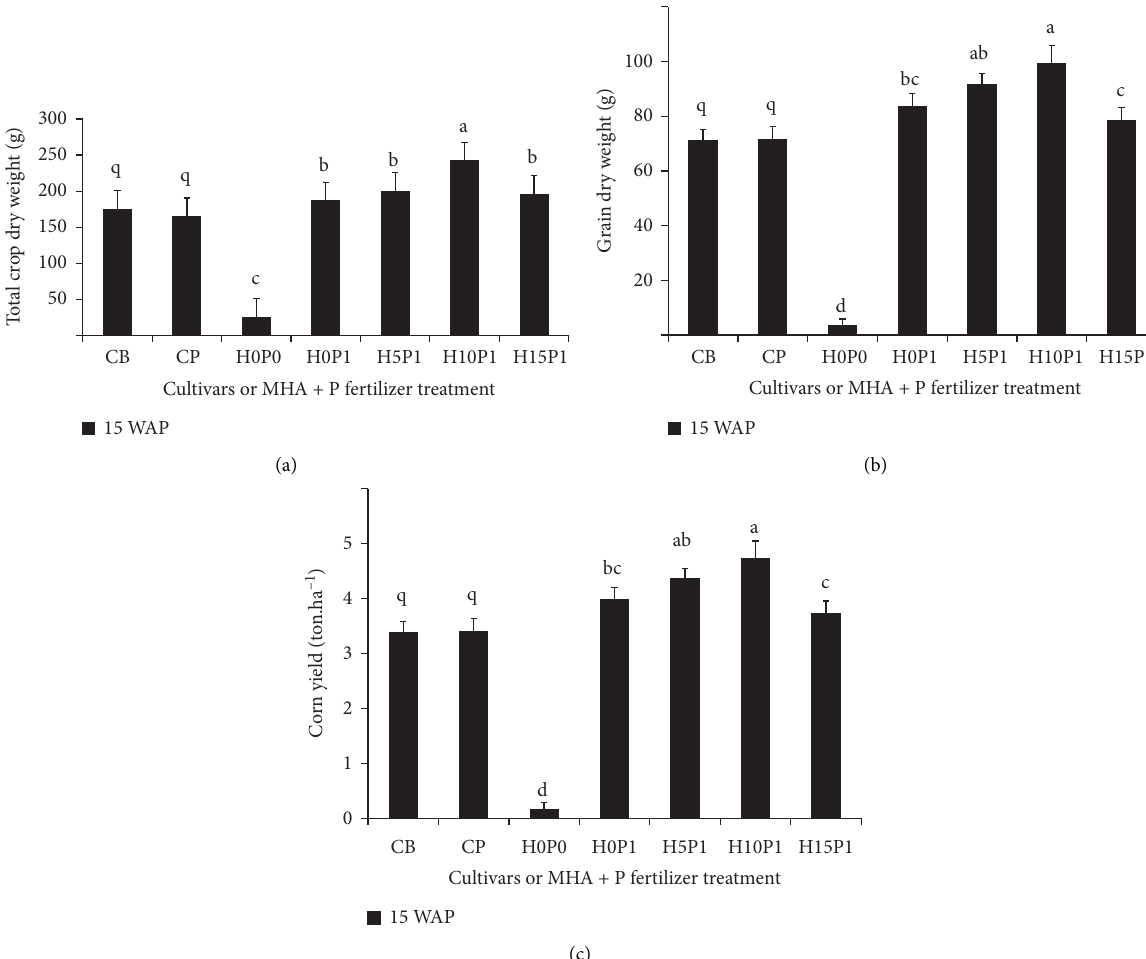
Figure 5: Total crop dry weight (a), grain dry weight (b), and corn yield (c) at 15 weeks after planting (WAP). CB is Bisi 2 hybrid corn, CP is Pioneer 35 hybrid corn. H 0 P 0 is the control, H 0 P 1 is 0mg kg − 1 composted manure (MHA)+P fertilizer, H 5 P 1 is combined 35mg kg − 1 MHA +P fertilizer, H 10 P 1 is combined 75mg kg − 1 MHA+P fertilizer, and H 15 P 1 is combined 110 mg kg − 1 MHA +P fertilizer. The rate of P fertilizer in each P 1 treatment was equivalent to 120mg P 2 O 5 kg − 1 air-dried soil. Values followed by the same lowercase letter in a column were not significantly different based on Duncan’s multiple range test at p < 0 . 05. The results presented are the mean+standard error of 9